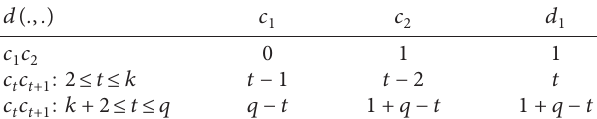
Table 6: Codes of inner edges of GP ( q, 1 ) when q is even. d ( ., . ) Table 7: Codes of outer edges of GP ( q, 1 ) .